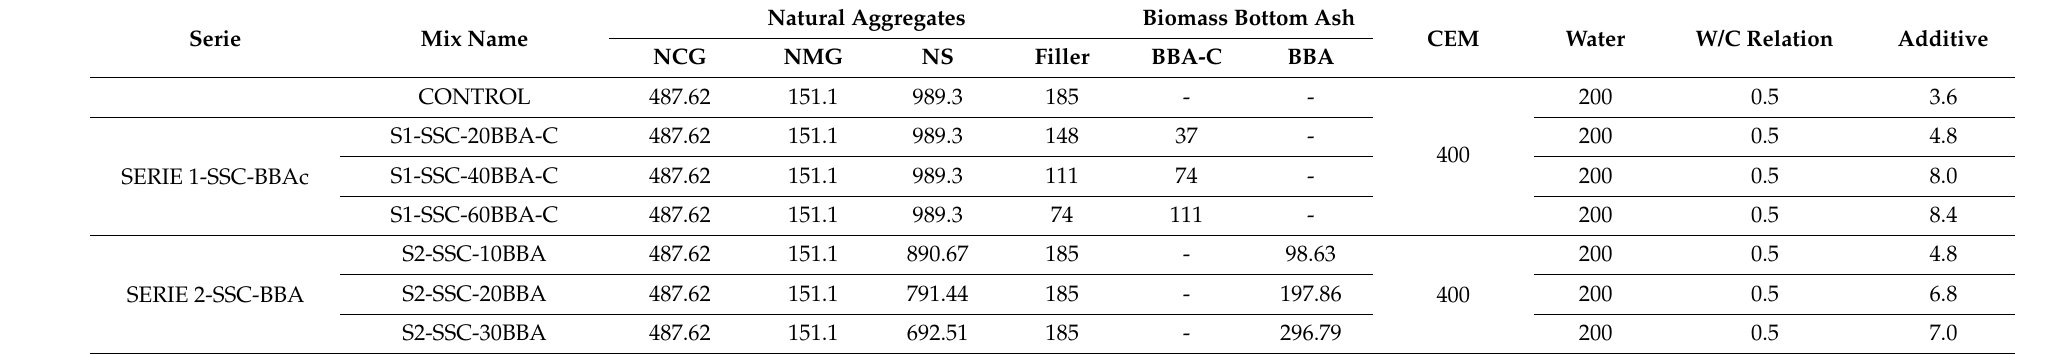
Table 3. Concrete mix proportions (kg/m 3